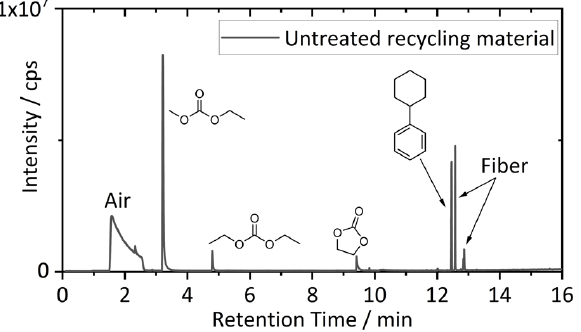
Figure 4. SPME-GC-MS chromatogram after preconcentration for 10 s from the headspace above the untreated recycling material.